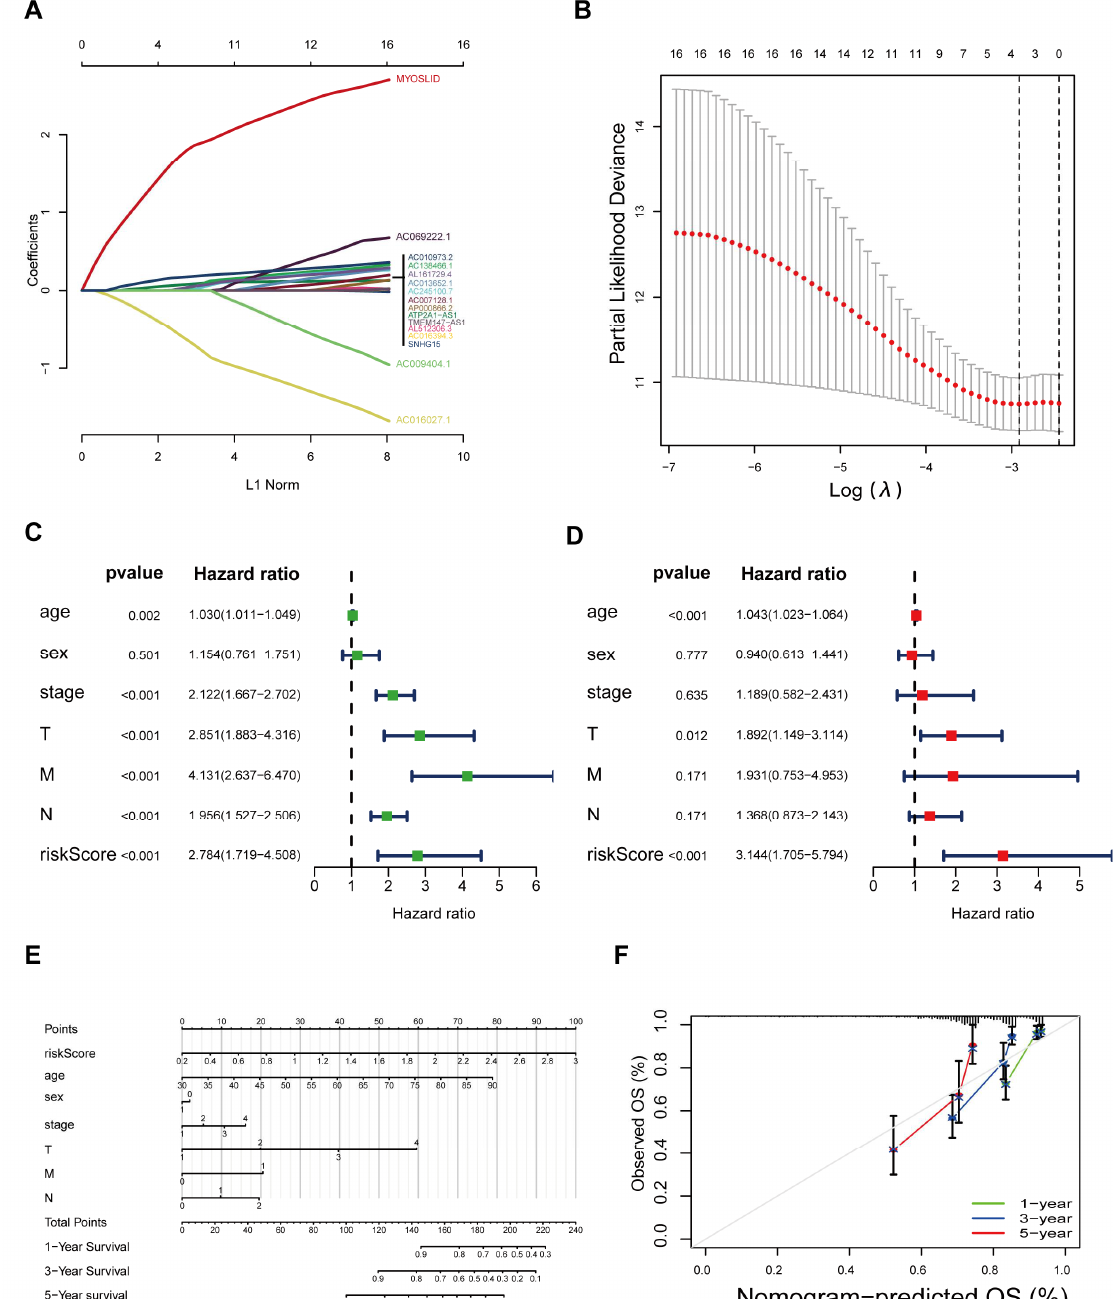
Figure 3. Establishment and preliminary prognostic validation of a 4-necroptosis-related lncRNA model. ( A , B ) Cvfit and lambda curves showing the correct criteria in the process of generating the model. ( C , D ) Univariate/multivariate Cox regression analysis comparing the prognostic value of the model with those achieved using other clinicopathological characteristics. ( E ) OS-related nomogram to predict the 1-, 3-, and 5-year OS rates in CRC patients. ( F ) Calibration curve to evaluate the predictive accuracy of the model. The grey diagonal line in the centre represents the ideal predictive